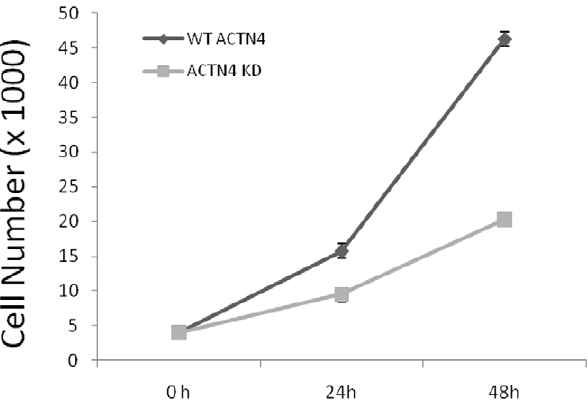
Figure 6. Knockdown of ACTN4 decreases cell proliferation. Both WT ACTN4 and ACTN4 KD fibroblasts were seeded at a density of 40K cells per well in 6-well Petri-dish plates. After culturing for appropriate time, all cells were harvested and only viable cells were counted on a hemacytometer. Data are the mean 6 s.e.m., measured from three independent experiments each in triplicate.